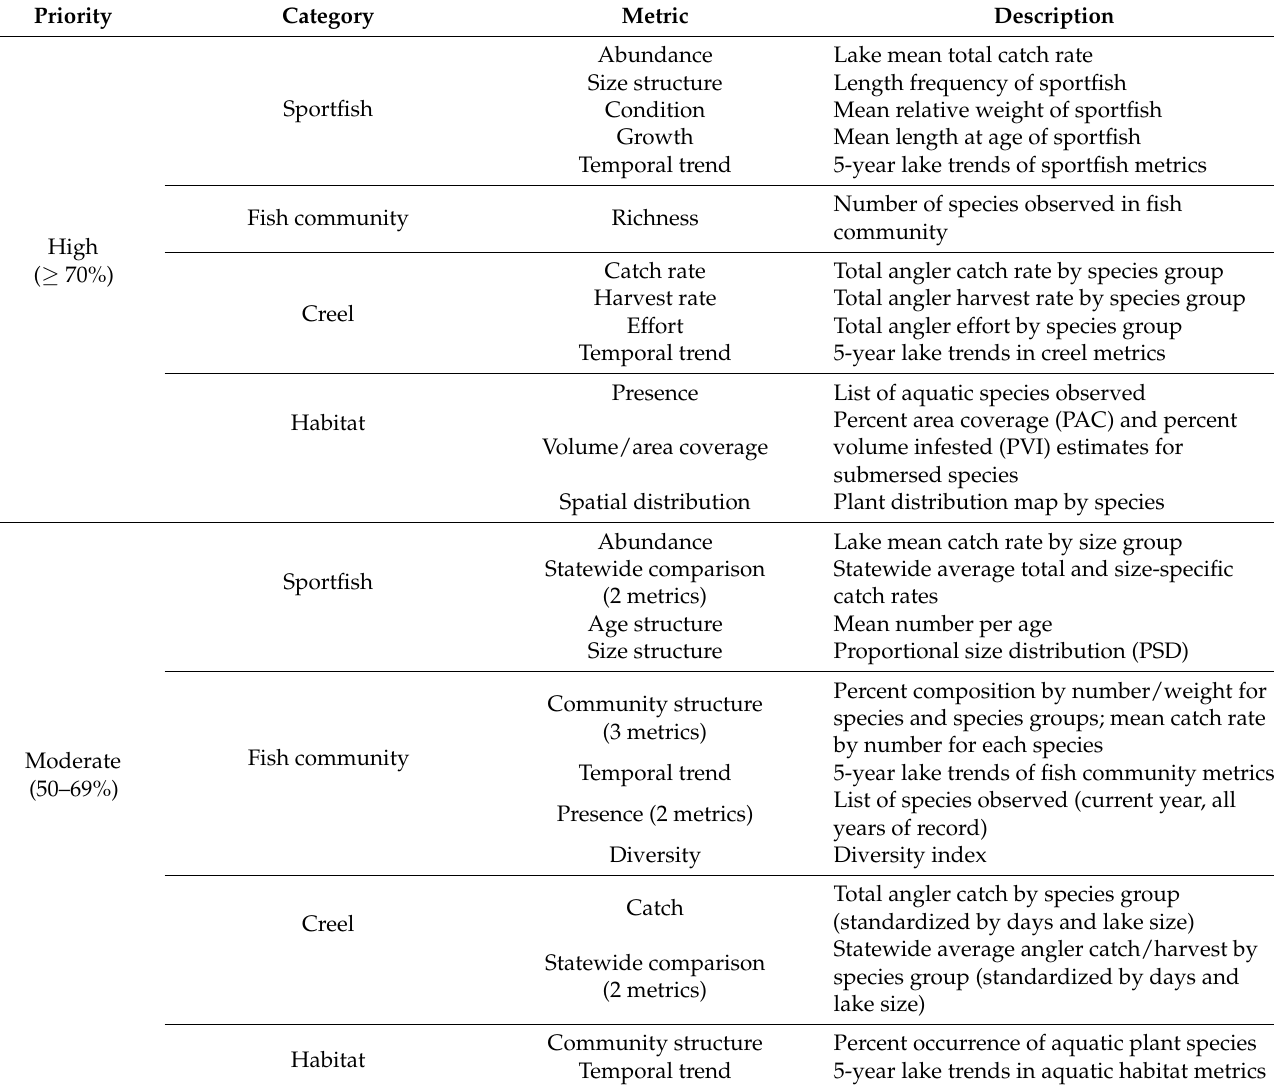
Table 8. List of priority metrics representing at least 50% of respondents. Note that several of the moderate-priority metric descriptions encompass more than one